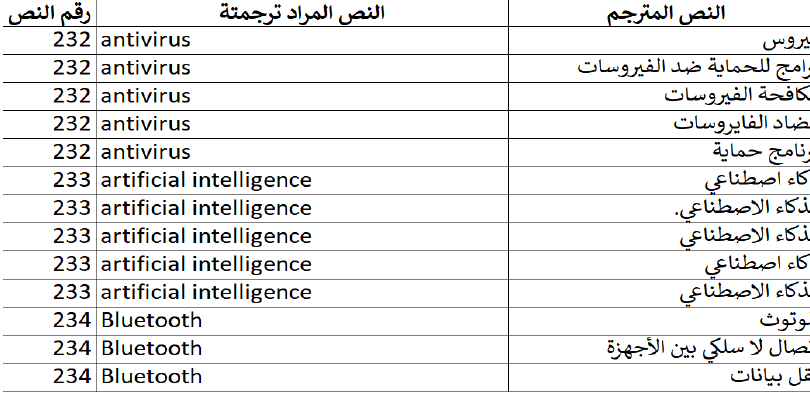
Figure 7. Generated dataset.